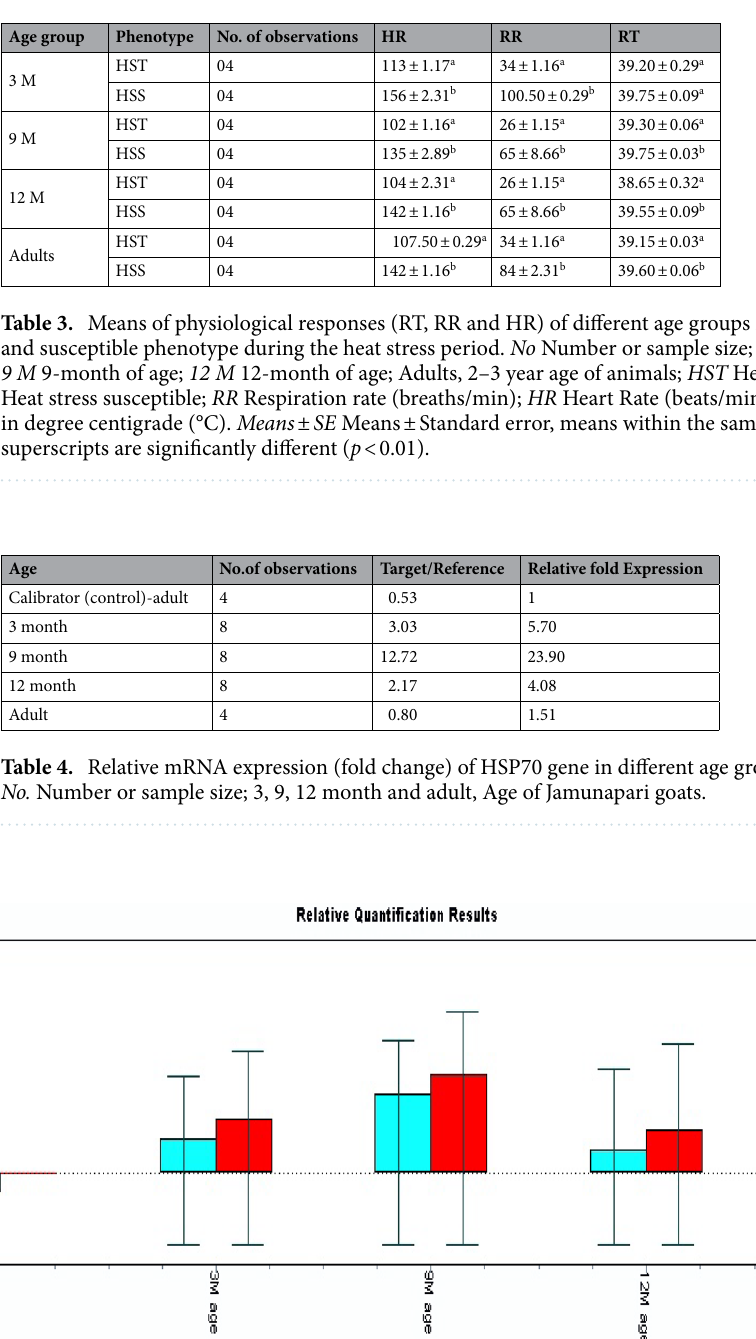
curve & melting peak are provided in Supplementary Fig. 3A and Fig. 3B. The relative m-RNA expression pat- tern of HSP70 gene in 3, 9, 12 months and adults ages showed 5.70, 23.90, 4.08 and 1.51 up-regulation compared to adult control (heat stress-susceptible) (Table 4 and Fig. 1). The m-RNA expression was significantly higher at